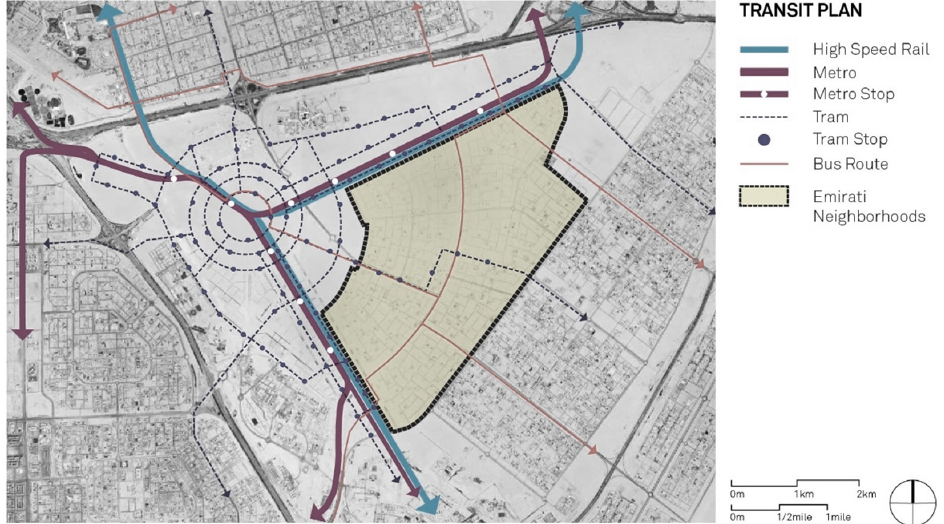
Figure 2. The transit plan of the Capital District. Diagram adapted by the authors from Abu Dhabi Urban Planning Council Report 2009 [8].